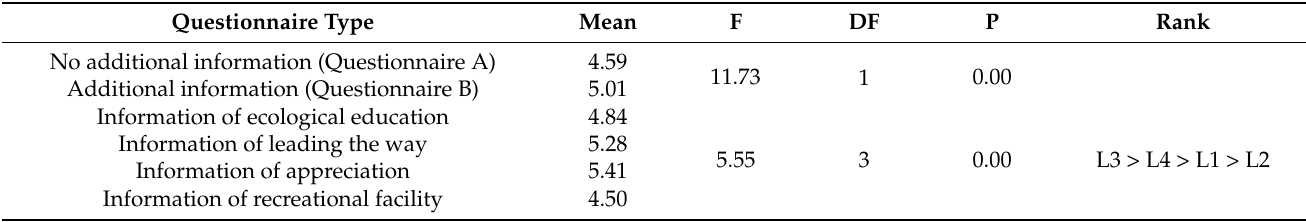
Table 6. One-way ANOVA test of the effects of the additional information on dead wood preferences and Tukey’s HSD test among the different types of additional information given.